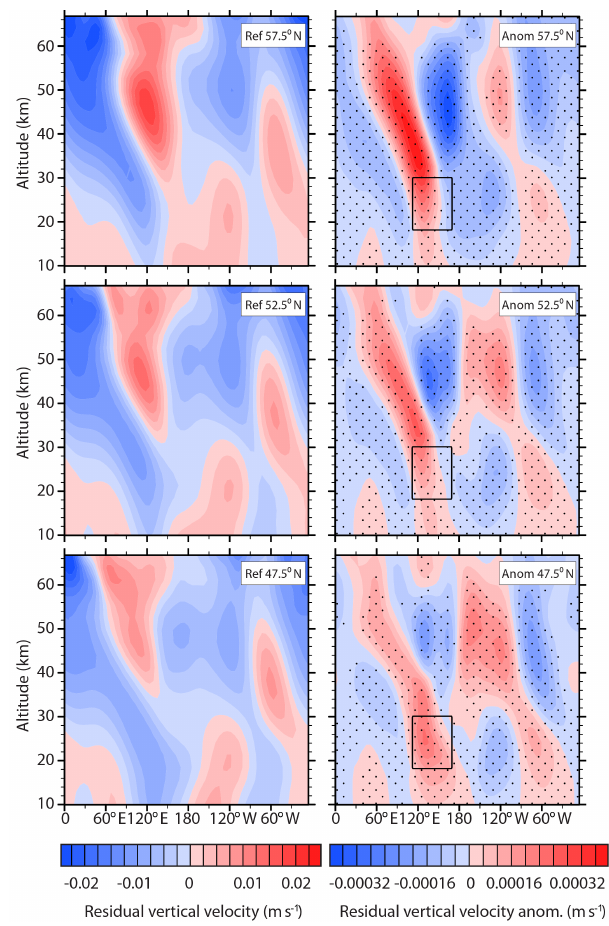
Figure 12. Mean (7th to 30th day January longitudinal cross sec- tions of reference residual vertical velocity [ms − 1 ] (on the left) and Box0.1 simulation anomalies (on the right) at selected latitudes. The contours illustrate the position of the artificial GWD. The statistical significance of the mean anomalies was computed by a t test and regions with p values < 0 . 05 are